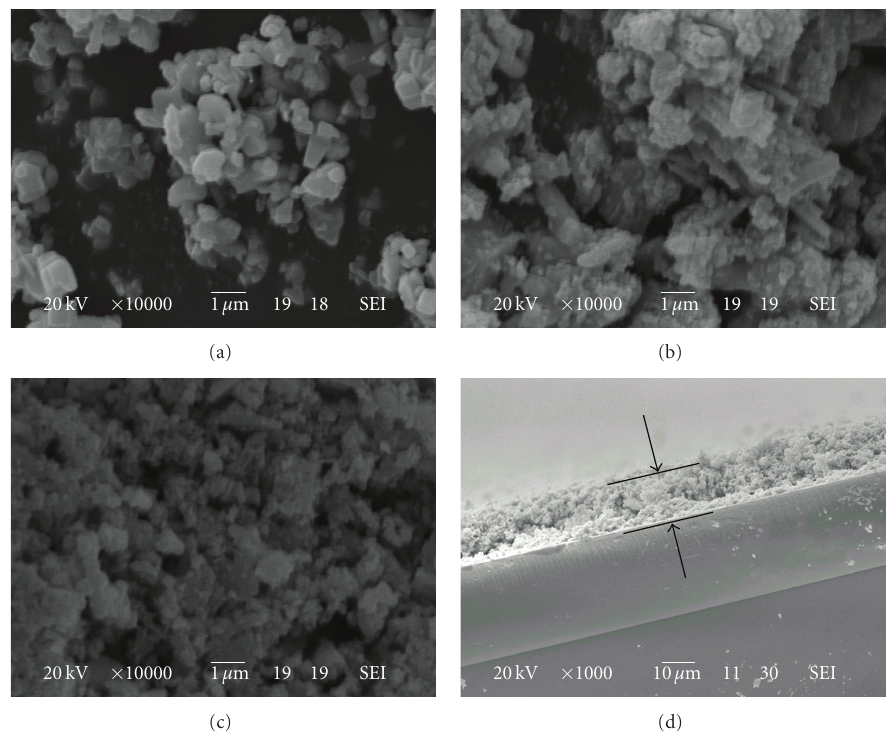
Figure 2: SEM images of BaSnO 3 powders prepared by di ff erent particles: (a) CP, (b) HT, and (c) SSR. (d) Cross-section of a 15 μ m thick BaSnO 3 film electrode.